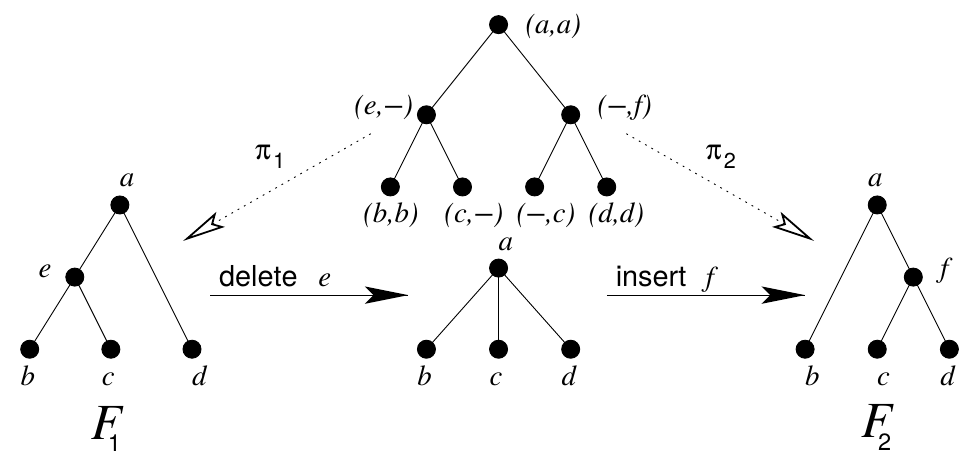
Figure 3. Alignment of two forests F 1 and F 2 ( top ) and a sequence of edit operations (relabel, delete, insert) in order to transform F 1 into F 2 ( below ). Tree alignment conserves the structures of both original trees that can be recovered using the mapping π 1 or π 2 , respectively. For more details, see Section